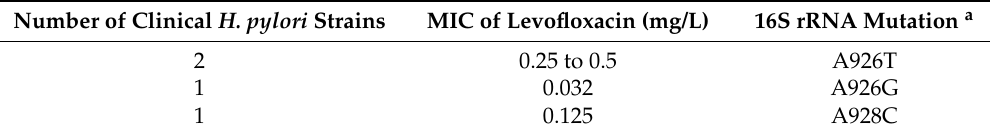
Table 7. Point mutations identified by WGS in the primary binding site of tetracycline in the 16S rRNA gene at nucleotide positions, 926 to 928, and their corresponding MICs. Number of Clinical H. pylori Strains MIC of Levofloxacin (mg/L) 16S rRNA Mutation a 2 0.25 to 0.5 A926T 1 0.032 A926G 1 0.125